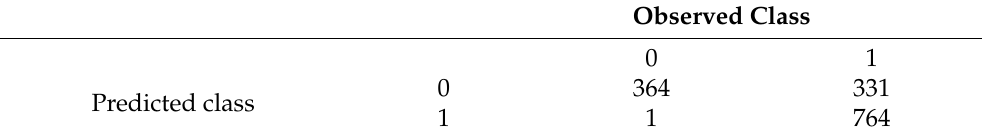
Table 7. Confusion matrix for the SVM model on the test set in the two-class classification problem.